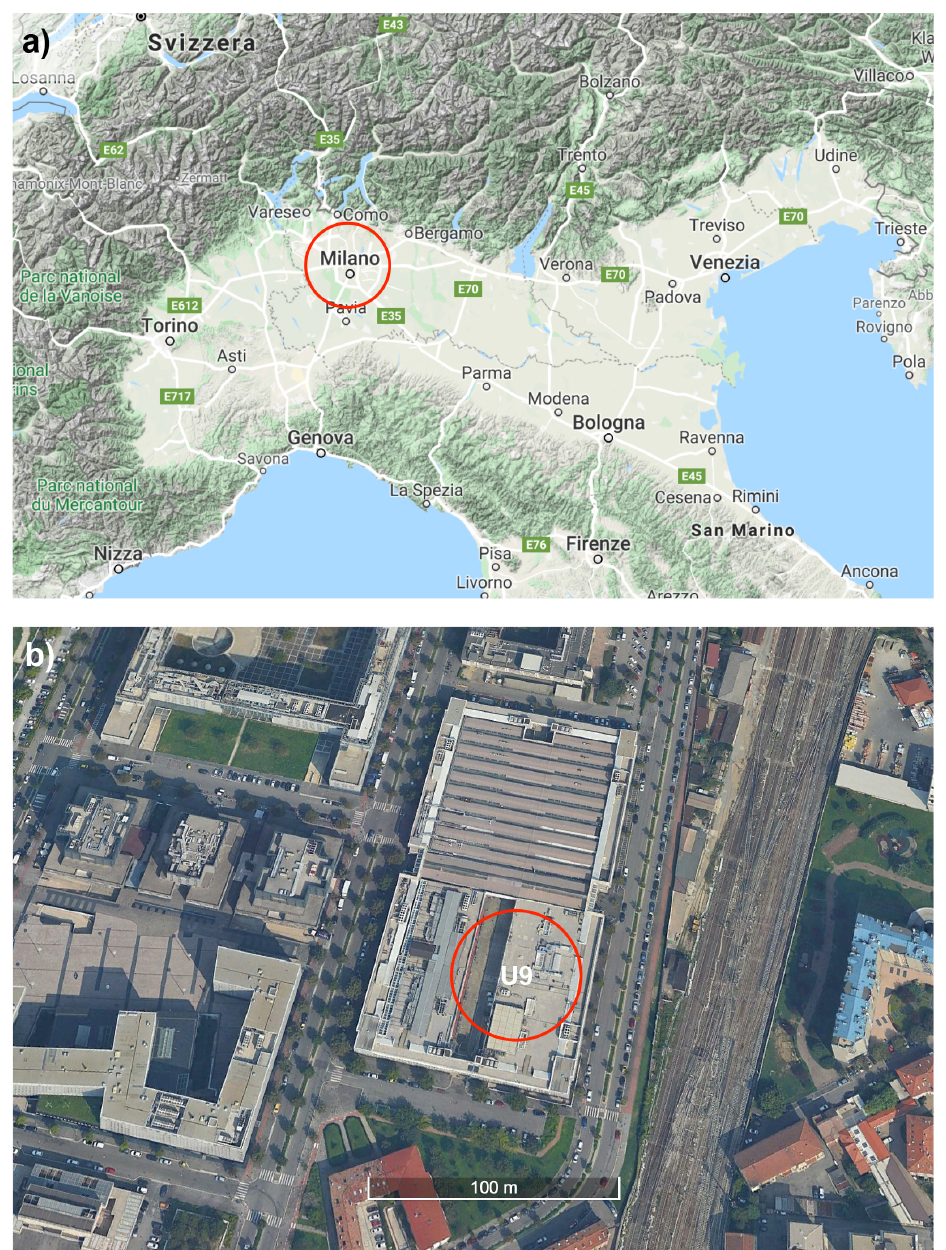
Figure 1. (a) Location of the Milan sampling site in the Po Valley, Italy; (b) the U9 sampling site on the rooftop (10ma . g . l . ) of the University of Milano-Bicocca. The copyright holder of Fig. 1 is Google Maps (©Google Maps).